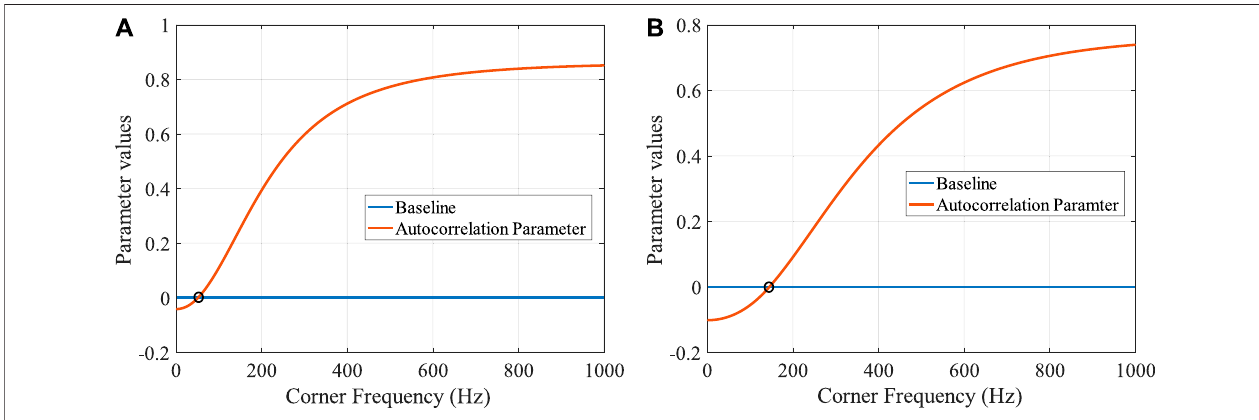
FIGURE4| AutocorrelationParametervaluesplotted forvarious corner frequencies usedasatrail.Asstated inthetext, welook atthesecondpoint fromthepeak in theAutocorrelationcurve.Thecorner frequencyat whichthisparametermatches thezero baseline canbeconsidered asthecorrectcorner frequencyforoursystem. Figures (A) and (B) are for two different laser powers, 14 and 54 mW, that is two different trap stiffnesses.